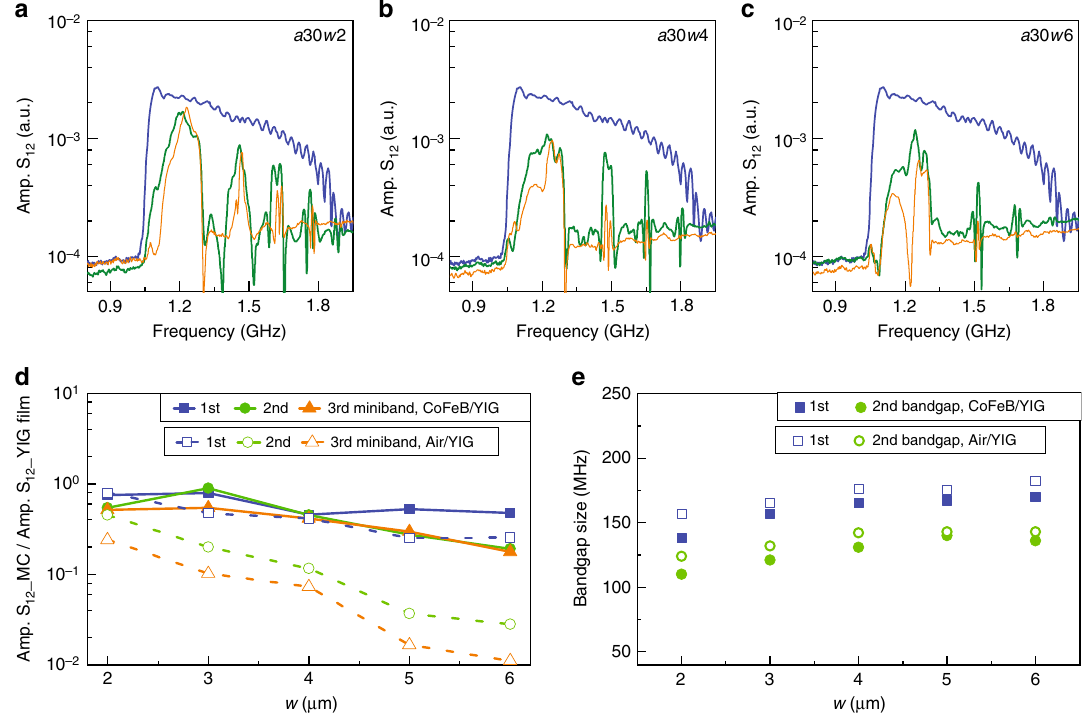
Fig. 4 Dependence of spin-wave transmission and bandgap size on groove width. a – c Transmission spectra of pure YIG (orange lines) and CoFeB/YIG (green lines) magnonic crystals with N = 4 grooves. The blue line depicts a reference spectrum measured on a continuous part of the same YIG fi lm. d Dependence of spin-wave transmission on groove width w in the fi rst three minibands. The amplitudes of the S 12 scattering parameter in the magnonic crystals (Amp. S 12 _MC) are compared to those recorded on continuous YIG (Amp. S 12 _YIG fi lm). e Variation of the bandgap size with groove